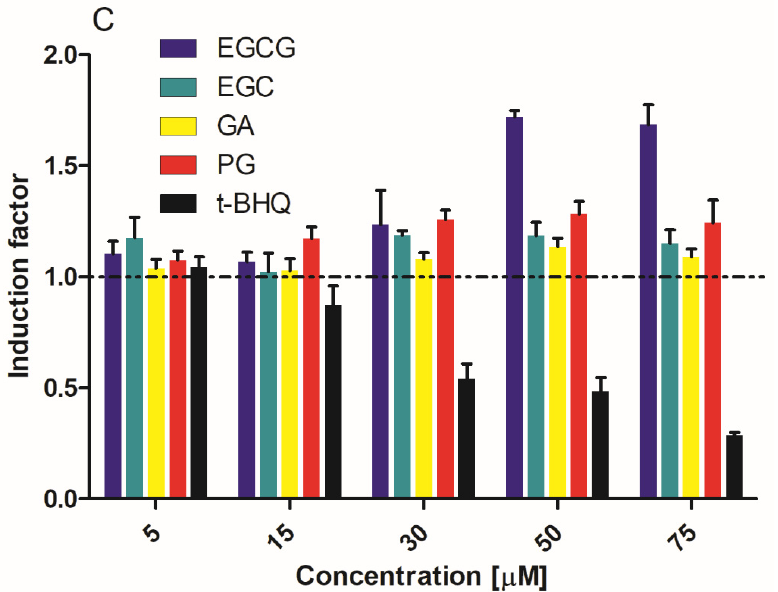
Figure 2. Induction of luciferase activity in U2OS-Nrf2 CALUX reporter cells after 24 h exposure to ( A ) EGCG, EGC, GA, PG or t-BHQ and ( B ) EGCG or PG at various concentrations, including a two-way ANOVA with Bonferroni multiple comparisons to evaluate the Nrf2 induction factors at the same exposure concentrations. The average IF of the positive control (20 µM curcumin) was 42.3. p values for main effects due to compounds and concentrations and their interaction are annotated below the figure. Statistical differences between two treatments are demonstrated (*, p < 0.05). ( C ) Luciferase induction in U2OS-Cytotox CALUX cells. The induction factors are presented as mean ± standard error of the mean (SEM) compared to solvent control and were derived from at least three independent experiments. EGCG, (-)-epigallocatechin gallate; EGC, (-)-epigallocatechin; GA, gallic acid; PG, pyrogallol; t-BHQ, tert-butylhydroquinone; Nrf2, nuclear factor-erythroid 2-related factor